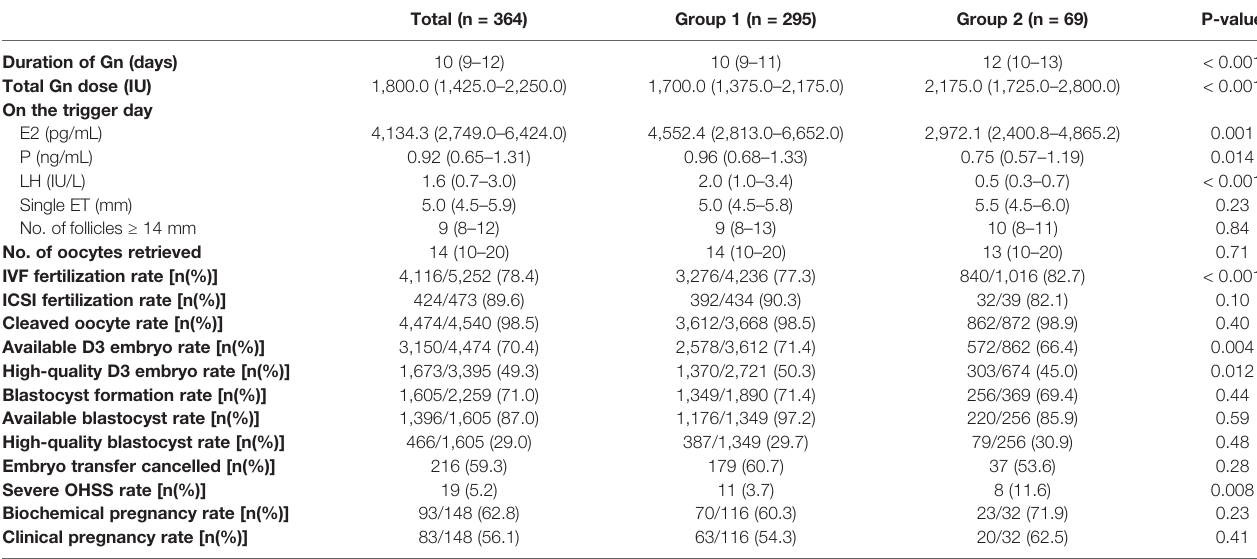
TABLE 2 | Comparison of clinical outcomes between the two groups.